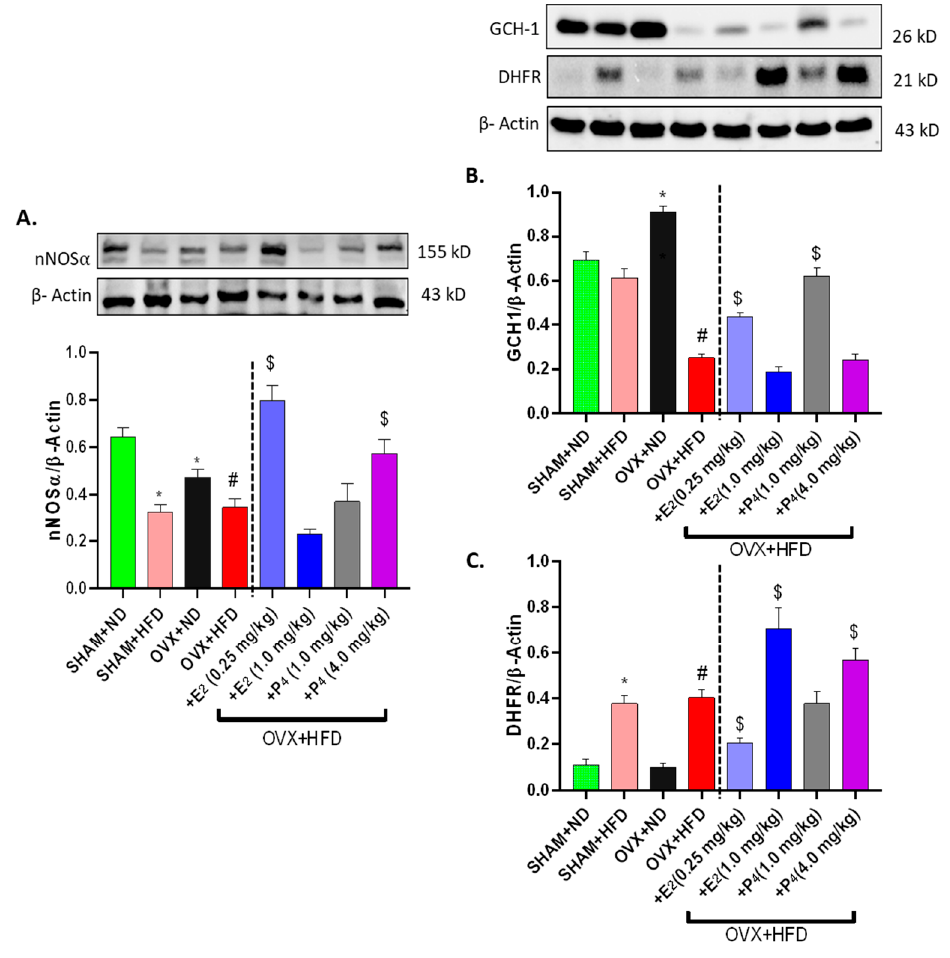
Figure 3. E ff ect of 17 β -Estradiol (E 2 ) and Progesterone (P 4 ) on gastric neuronal nitric oxide synthase (nNOS α ), GCH-1, and DHFR expressions in HFD-fed OVX mice. Representative immunoblot and densitometry analysis data for ( A ) nNOS α , ( B ) GCH-1, and ( C ) DHFR protein expression. Stripped blots were re-probed with β -actin. Data were normalized with housekeeping protein ( β -actin). Bar graphs showed a ratio of target gene or protein with β -actin. Data were analyzed using one-way ANOVA by using graph pad prism software. Data are means ± SEM ( n = 6). * p < 0.05, significantly di ff erent from normal diet-fed sham-operated (SHAM + ND) mice. # p < 0.05, significantly di ff erent from normal diet-fed ovariectomized (OVX + ND) mice. $ p < 0.05, significantly di ff erent from high-fat diet-fed OVX (OVX + HFD)